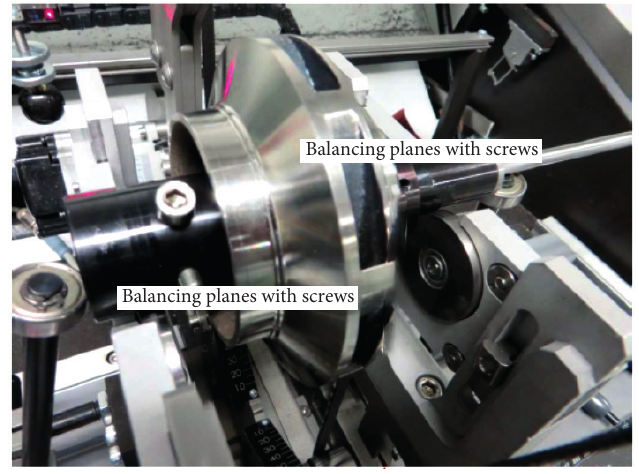
Figure 10. Impeller with adaptor on the balancing scale.